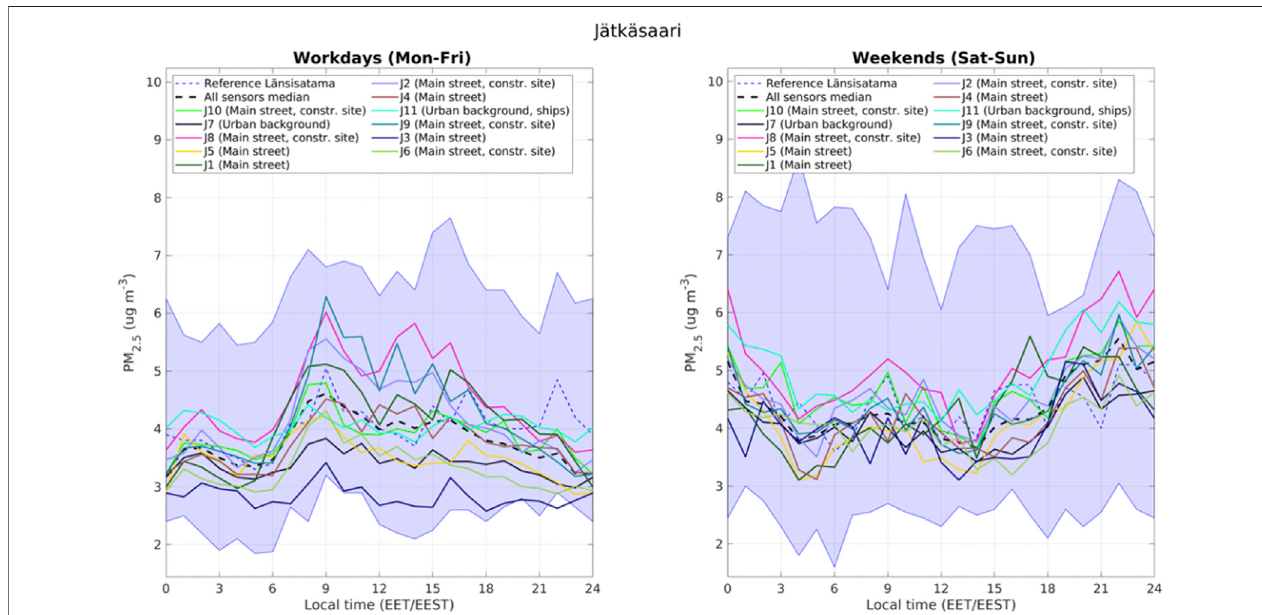
FIGURE 10 | Median diurnal cycles of PM2.5 mass concentration during 5-month period (1.8.-31.12.2020) for sensors located in Jätkäsaari (left) workdays (Mon- Fri) and (right) weekends (Sat-Sun). Reference measurements show median (dashed line) and 25th and 75th percentiles (shaded area) from nearest reference instrument. Black dashed line shows median diurnal cycle calculated for all data from that location.